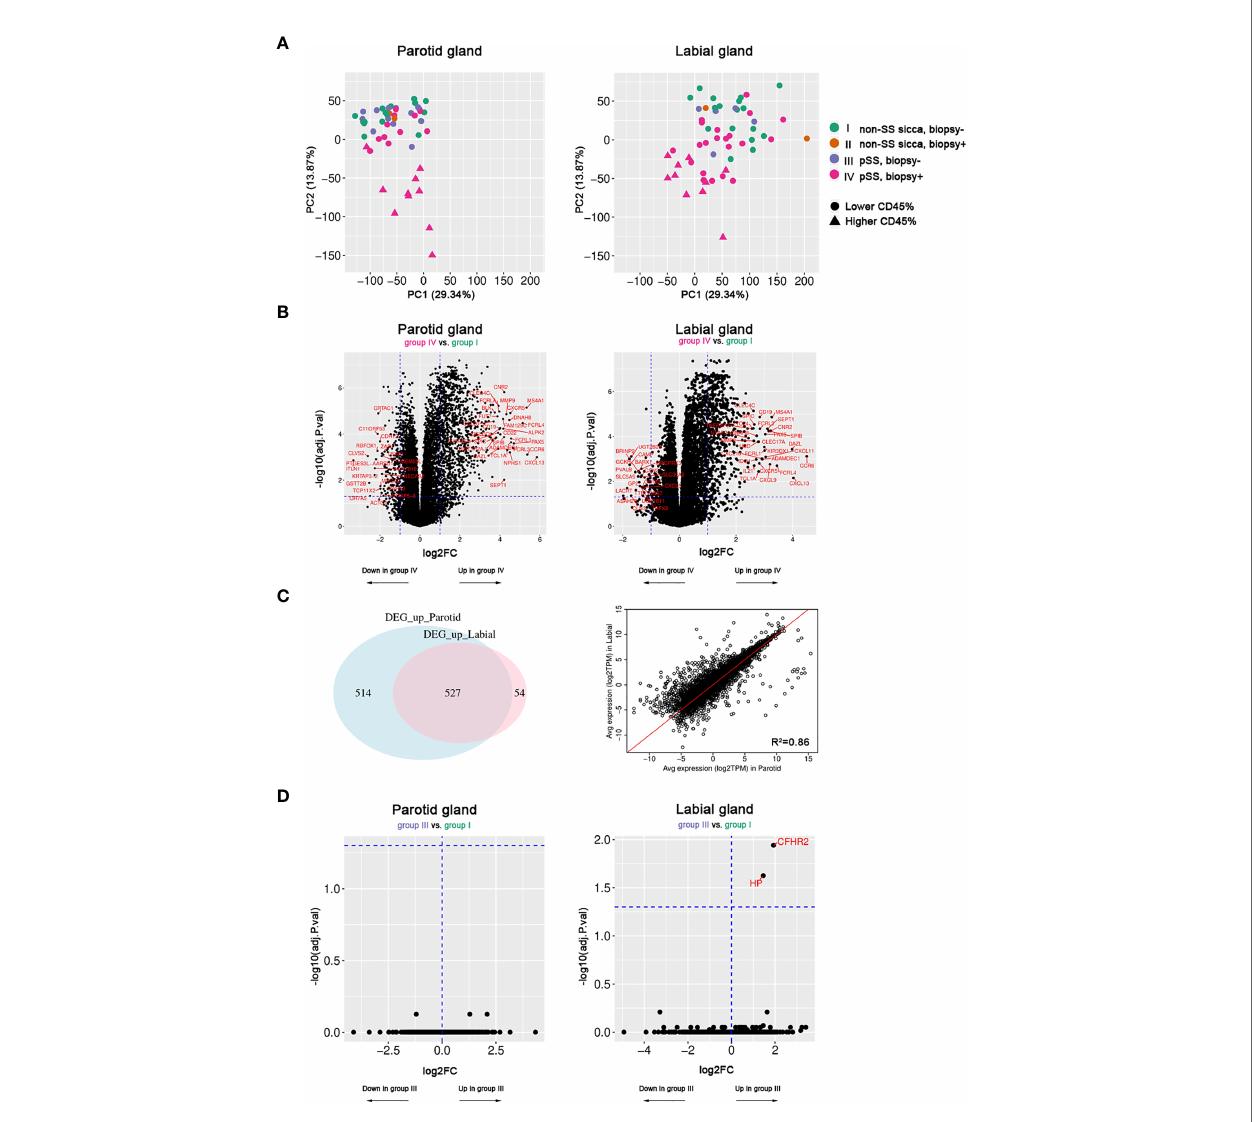
FIGURE 1 | Transcriptome analysis of paired parotid and labial gland samples. Fifty-two parotid samples and 57 labial samples were included. (A) Principal component analysis of parotid and labial gland samples. Colors indicate the patient groups and triangles indicate the 10 samples with the highest area fraction of CD45 + cells. (B) Volcano plots showing differentially expressed genes (DEGs) between biopsy-positive pSS patients (group-IV) and biopsy-negative non-SS sicca patients (group-I) for parotid and labial gland samples. (C) Venn diagram of (overlapping) DEGs between parotid and labial gland samples and correlation plot for up- and down-regulated genes (adj.p<0.05, log2FC>1) in either tissue. (D) Volcano plots showing hardly any differential gene expression between biopsy-negative pSS patients (group-III) and biopsy-negative non-SS sicca patients (group-I) for parotid and labial gland